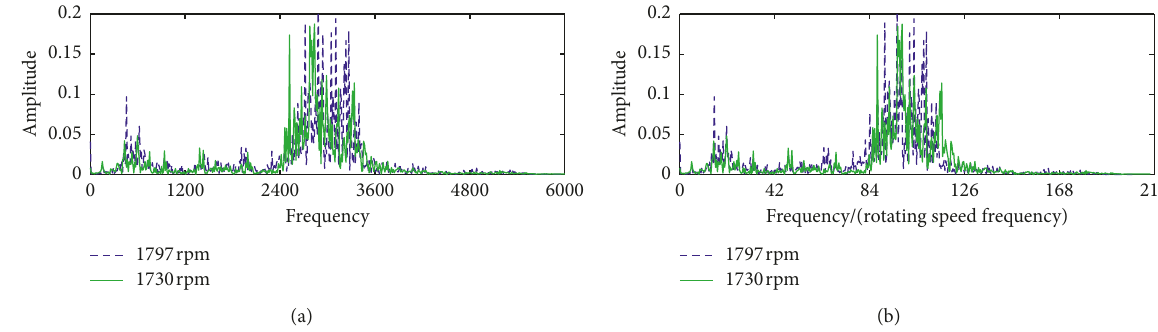
Figure 1: A comparison of spectrum image of before and after adjusting: (a) the original spectrum, (b) the adjusted spectrum. Image acquisition to obtain M adjusted images ( w × h pixels) Calculate the averaged image, i.e., A .